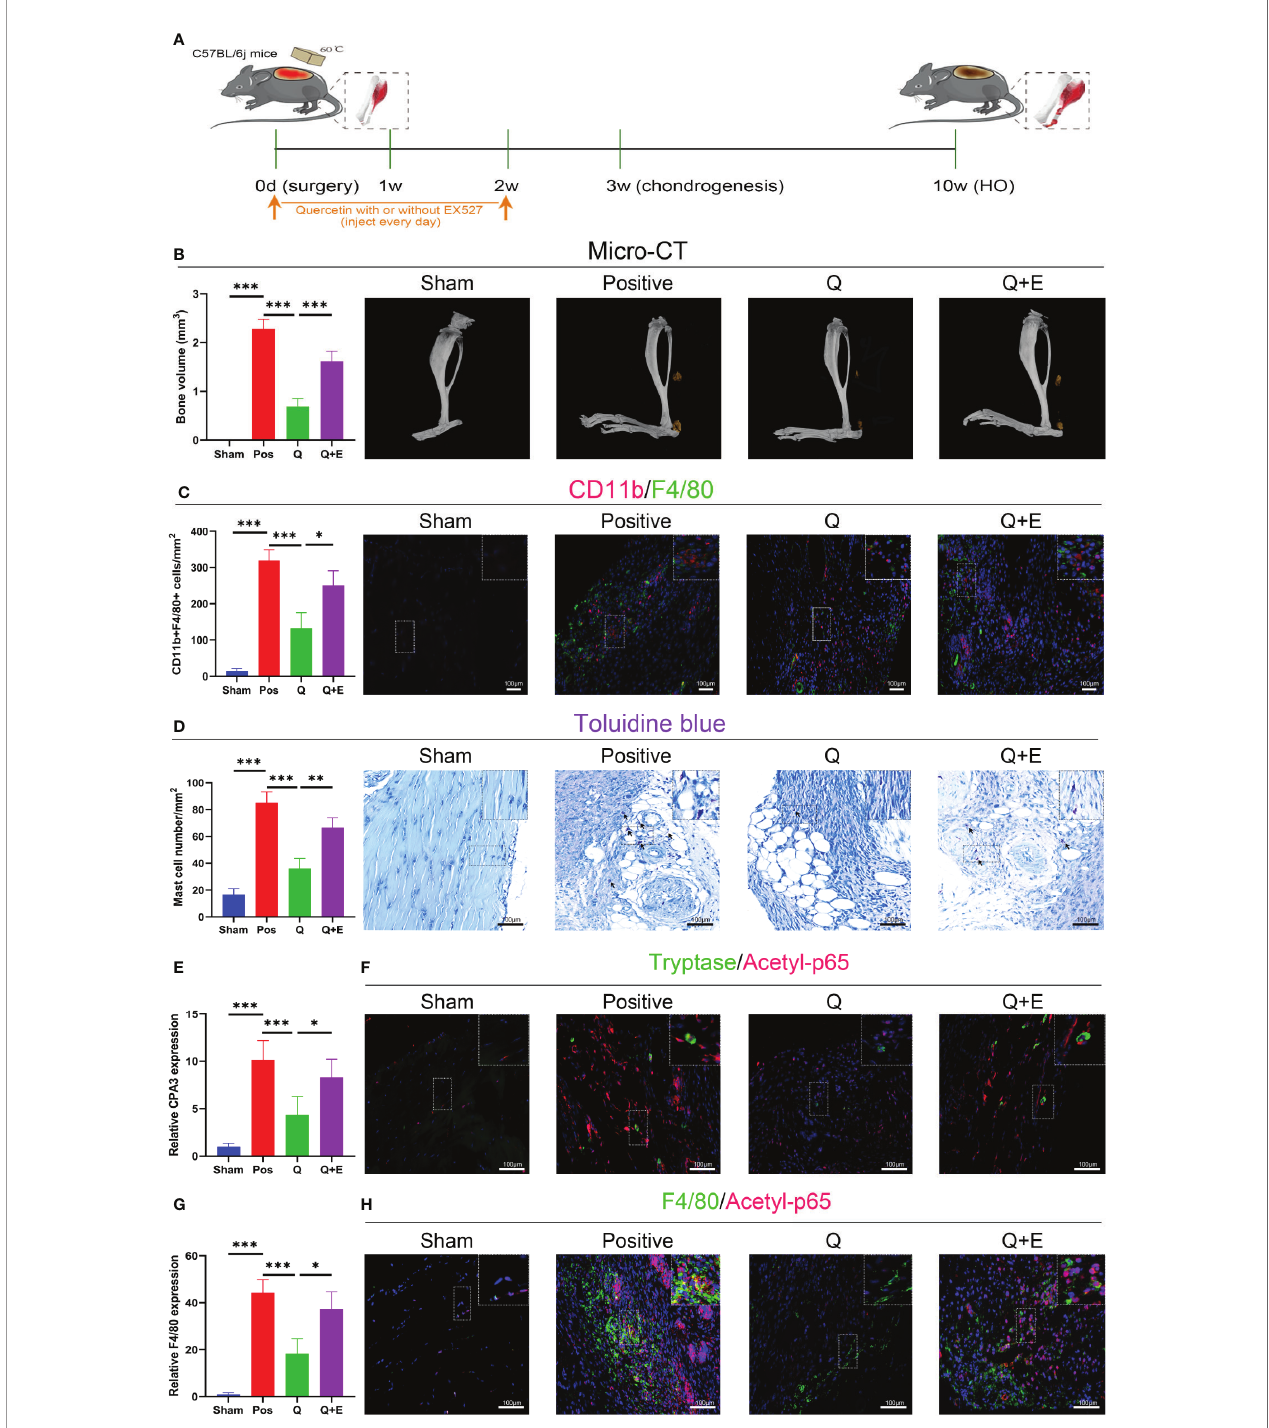
FIGURE 10 | Quercetin impeded immune cell in fi ltration and HO by activating SIRT1 in vivo . (A) Schematic depiction of the indicated treatment protocols for animal experiments. (B) Micro-CT scanning for observation and quanti fi cation of HO formation. (C) Double fl uorescence staining of CD11b and F4/80 7 days after burn/ tenotomy and quanti fi cation of CD11b+F4/80+ cells. (D) Toluidine blue staining for observation and quanti fi cation of mast cells 7 days after burn/tenotomy. (E) Relative gene expression of the mast cell marker CPA3 as determined by qRT-PCR. (F) Double fl uorescence staining of tryptase and acetyl-p65 7 days after burn/tenotomy. (G) Relative gene expression of macrophage marker F4/80 as determined by qRT-PCR. (H) Double fl uorescence staining of F4/80 and acetyl-p65 7 days after burn/tenotomy. Original magni fi cation is 40x. Inserts are approximately 3.5x magni fi ed images of the boxed area. N=4/group. ***P <